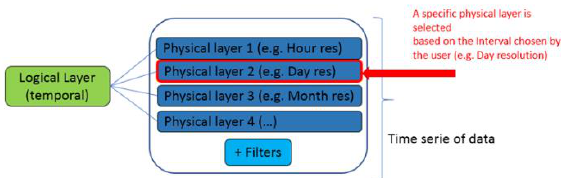
Figure 7. Time Manager Widget